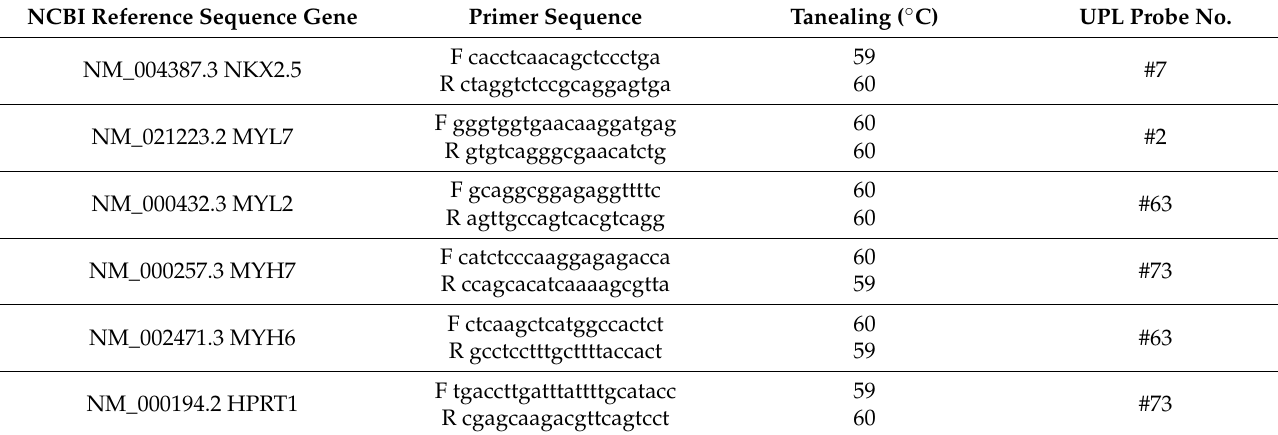
Table 1. Primer sequences for target and reference genes used in qRT-PCR assays; F = forward primer (5 (cid:48) -3 (cid:48) ), R = reverse primer (3 (cid:48) -5 (cid:48) ). NCBI Reference Sequence